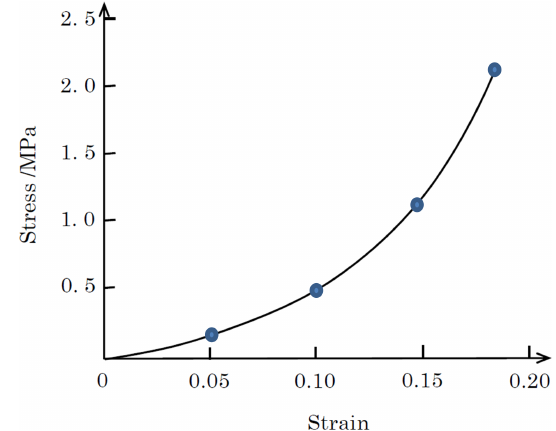
Figure 7. Stress-strain response adopted in FE analysis. The points are in the data table of the multi-linear kinematic hardening rule. The data are from Cao et al. (2012).